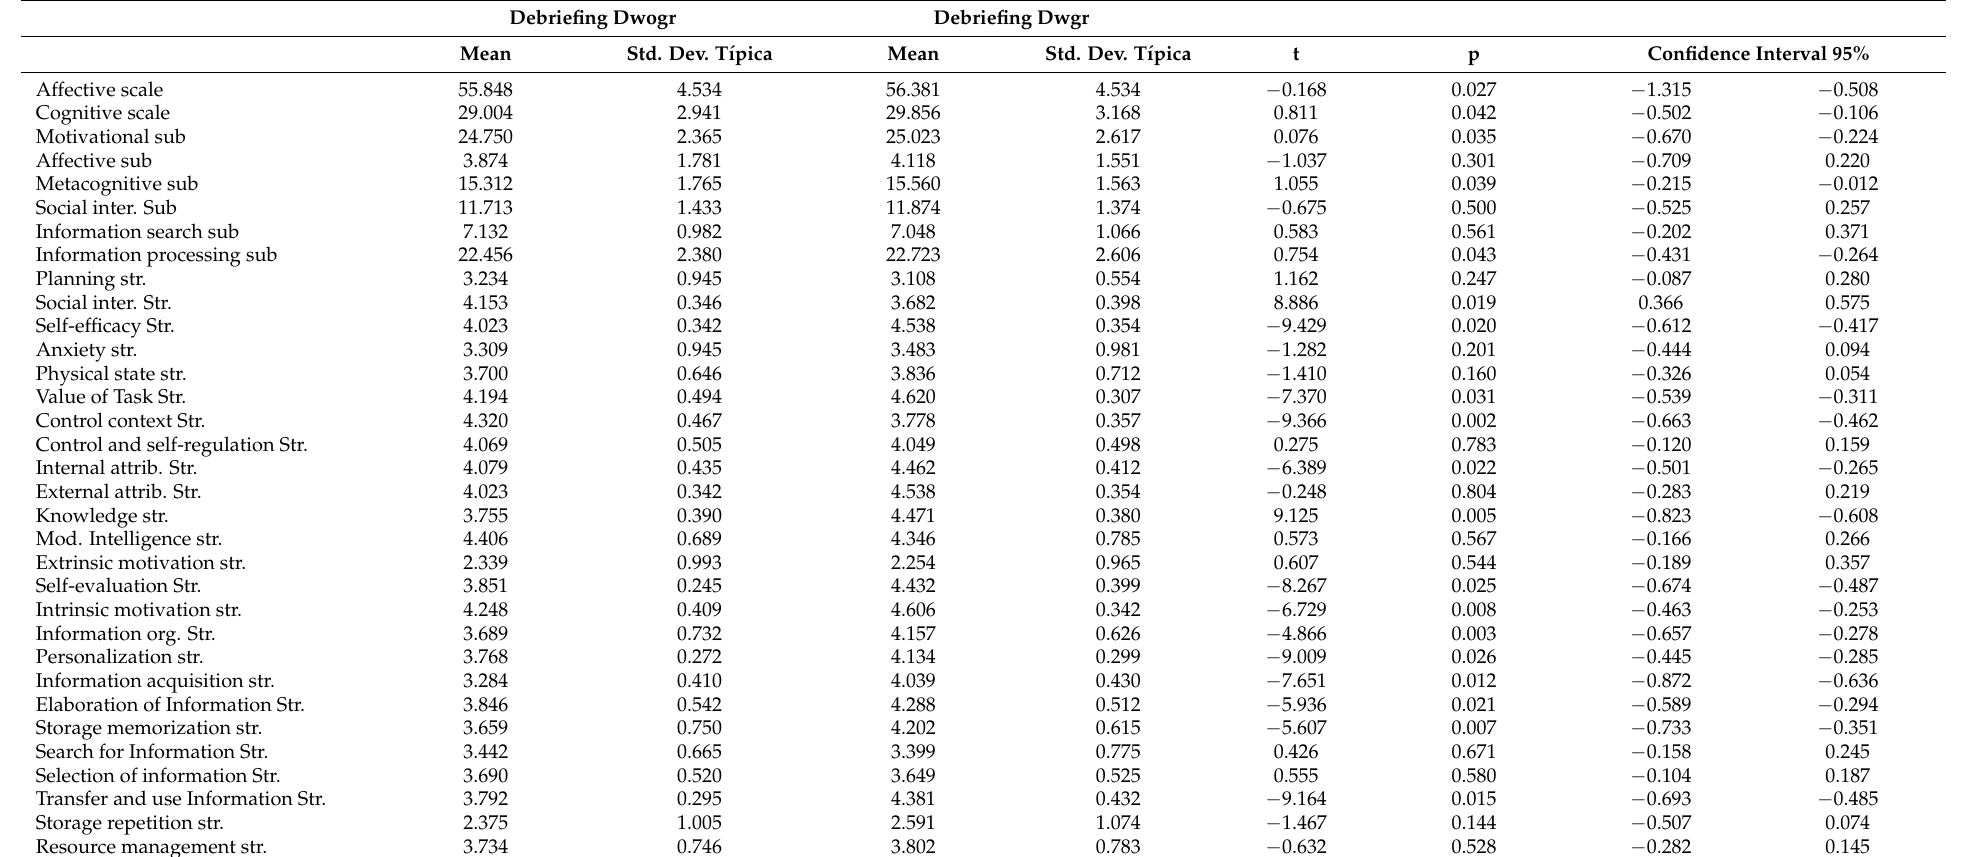
Table 3. Differences in means, with Student’s t test for independent samples, between motivation and learning strategies according to the CEVEAPEU and the type of debriefing. Debriefing Dwogr Debriefing Dwgr Mean p Confidence Interval 95% Affective